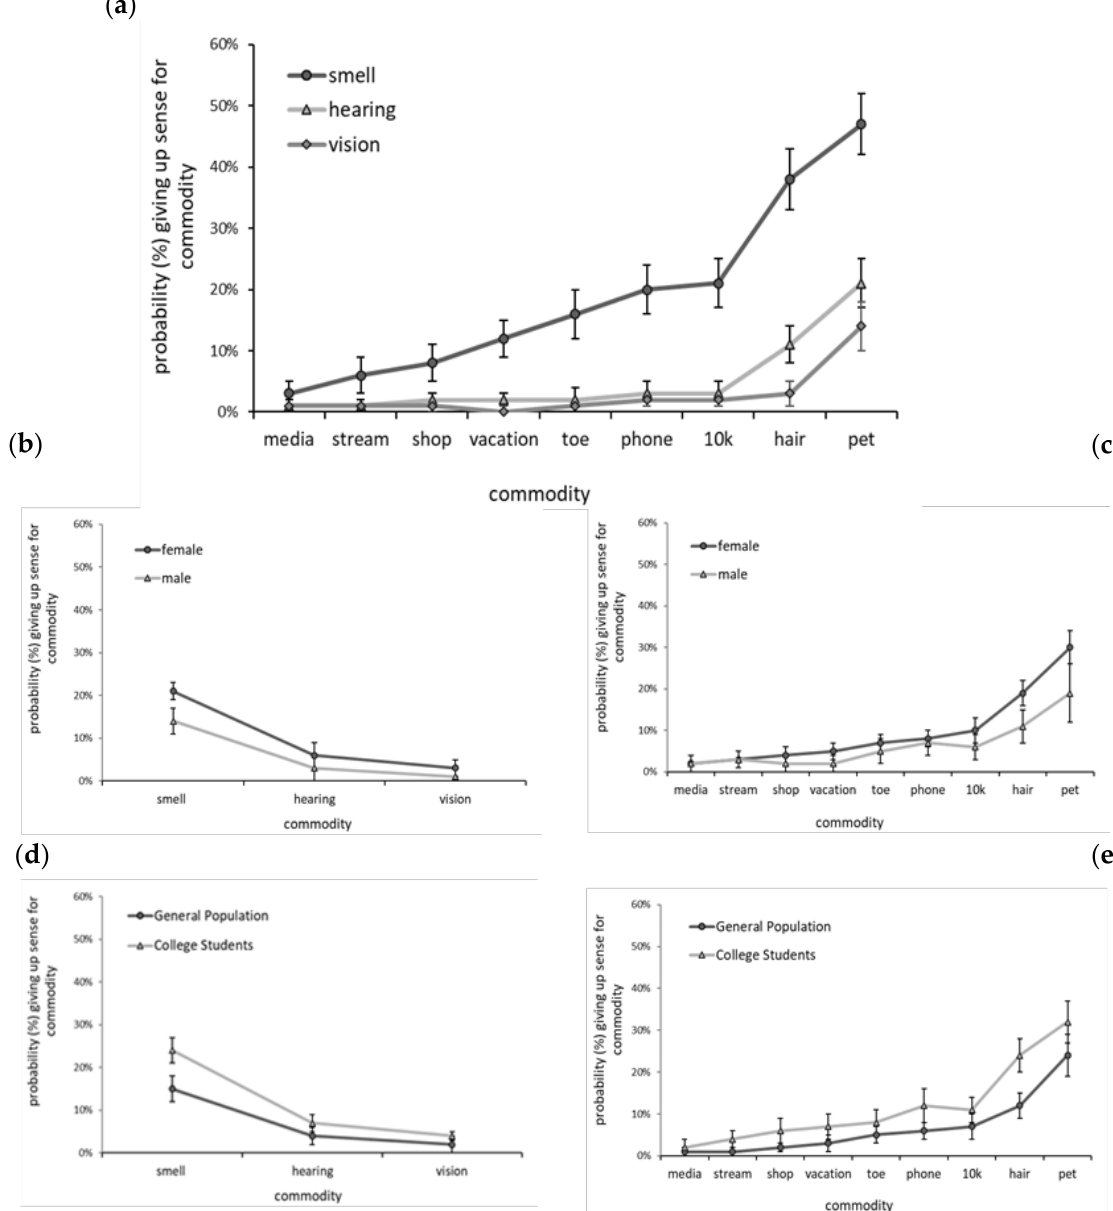
Figure 4. Probability of giving up senses ( a ) across all respondents by sense and commodity, ( b ) collapsed across commodities by sense for genders, ( c ) collapsed across senses by commodity for genders, ( d ) collapsed across commodities by sense for general population and college student groups, and ( e ) collapsed across senses by commodity for general population and college student groups.